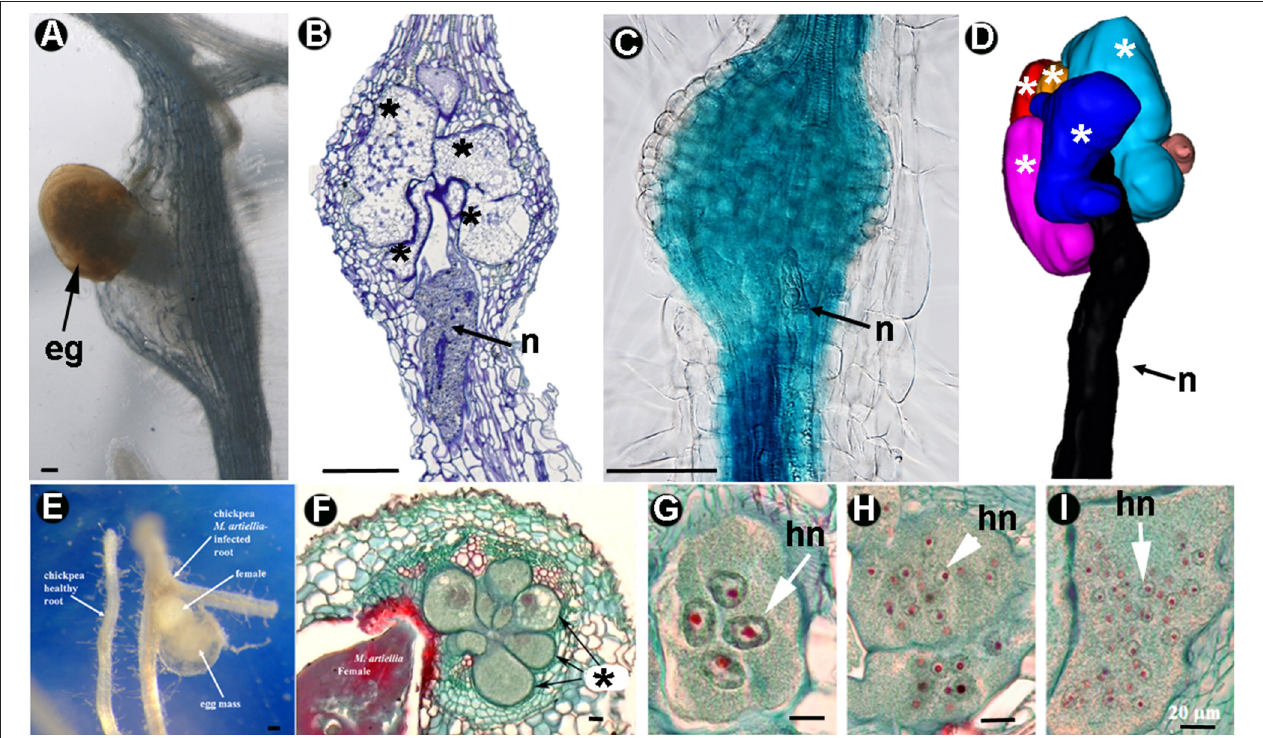
FIGURE 3 | Morphogenesis in root knot nematodes forming galls. Meloidogyne spp. (A–I) : (A) Egg mass (eg) protruding from a gall in a Cucumis sativus root infected by Meloidogyne javanica . (B) Longitudinal section of a gall from Arabidopsis thaliana showing multinucleate giant cells (*) and anterior region of the nematode (n). (C) Vascular tissue of a gall with GUS intense signal from an Arabidopsis transgenic marker line. (D) 3D reconstruction of giant cells (*) from Arabidopsis thaliana (Source: C. Escobar). Meloidogyne artiellia (E–I) : (E) Healthy and M. artiellia -infected chickpea roots, showing the prominent adult female covered by the egg mass. (F) Cross-section of M. artiellia -infected root showing the typical feeding site with giant cells (Palomares-Rius et al., 2011; with permission of Elsevier). (G–I) Detail of multinucleate giant cells induced by M. artiellia , M. arenaria , and M. javanica in chickpea roots, respectively ( Vovlas et al., 2005; with permission of The American Phytopathological Society). *, multinucleate giant cell; eg, egg-mass; hn, hypertrophied nucleus; n, nematode. Scale bars: A–C,E = 100 µ m; F–I = 20 µ m.